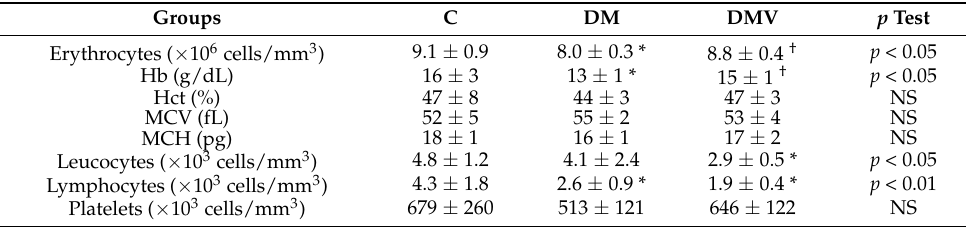
Table 4. Hematological parameters on day